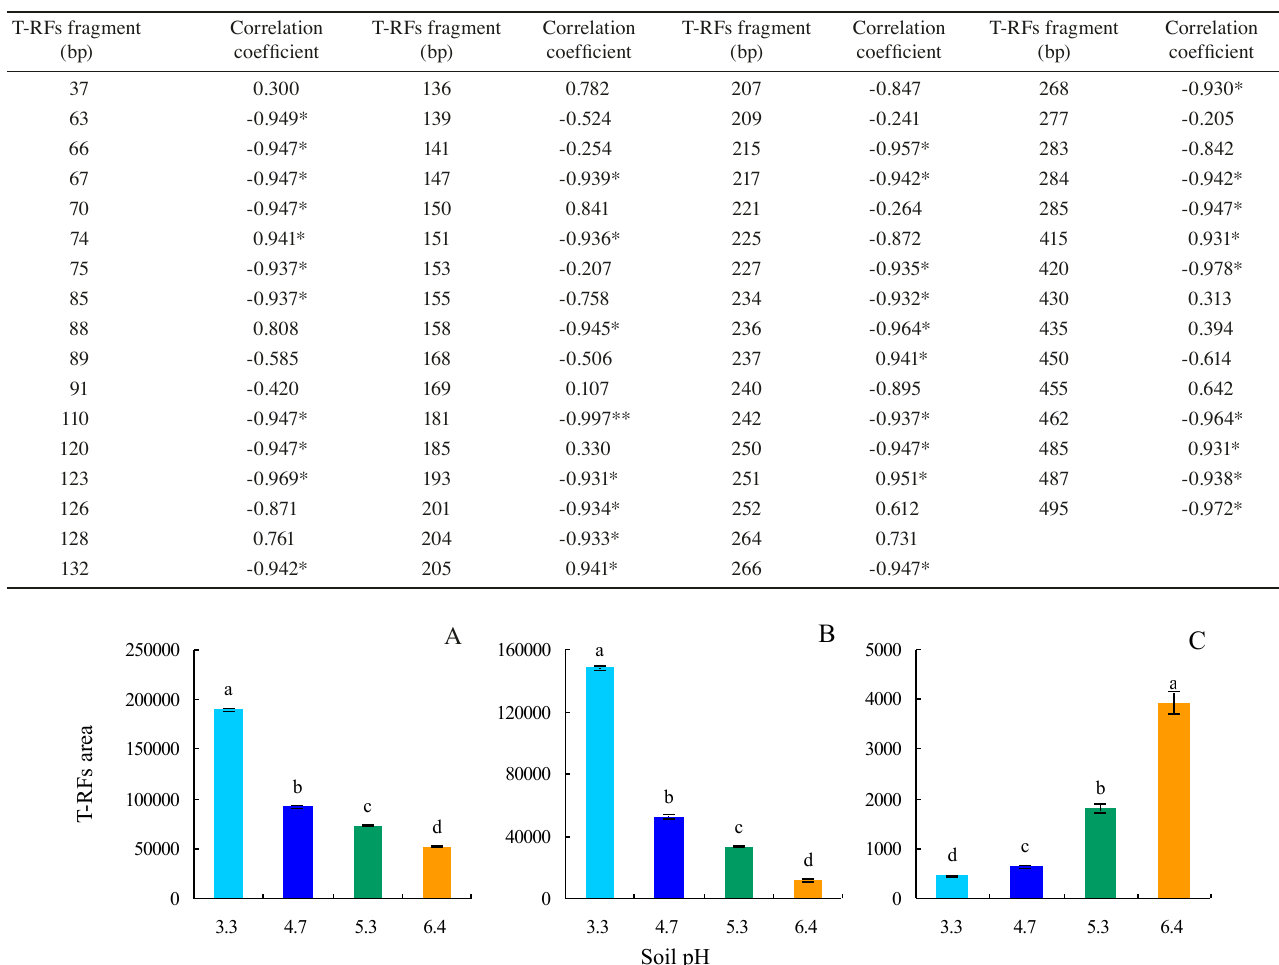
Tab. 2: Correlation analysis of T-RFs fragment area and soil pH value. T-RFs fragment